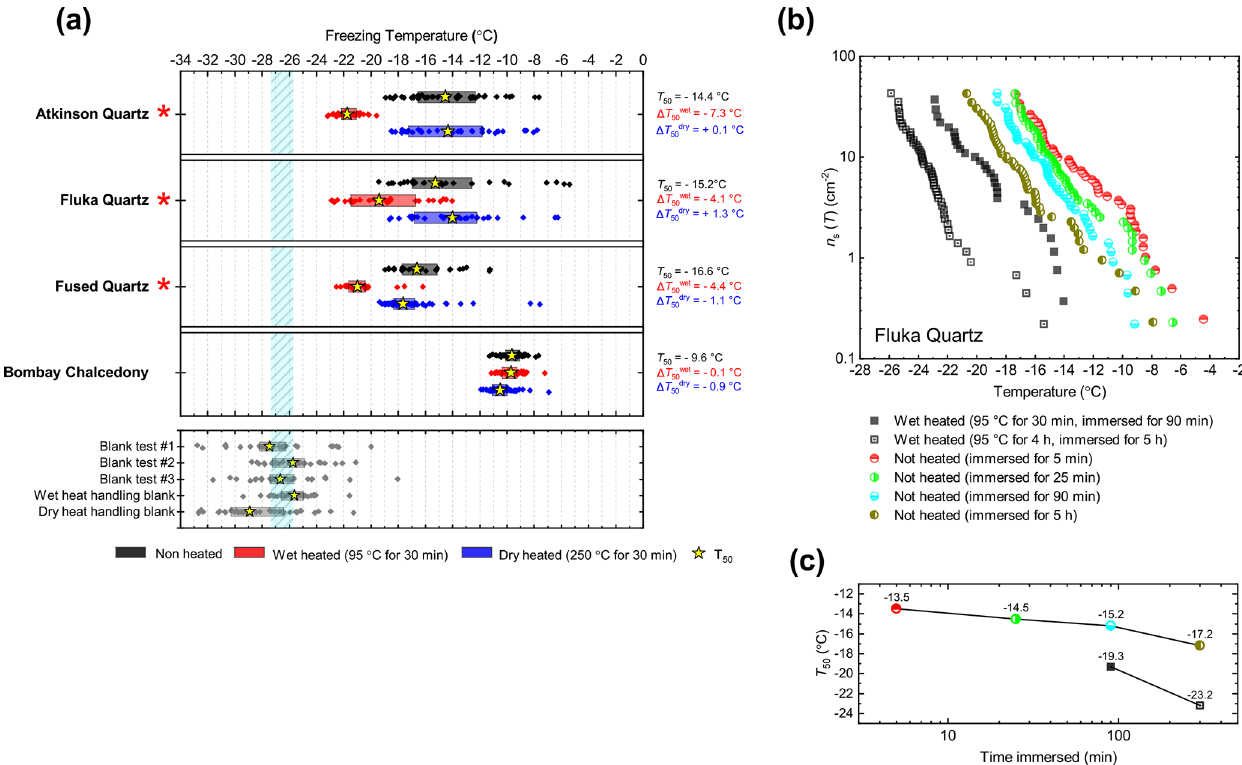
Figure 4. (a) Boxplot showing freezing temperatures before (black) and after heat treatments (red for wet heat, blue for dry heat) for all silica samples along with clean water blank and handling blank runs. (b) n s (T ) spectrum for Fluka quartz after wet heat treatment and room-temperature ageing, illustrating their relative rates of INA deactivation. (c) Time series of T 50 values for data plotted in (b)